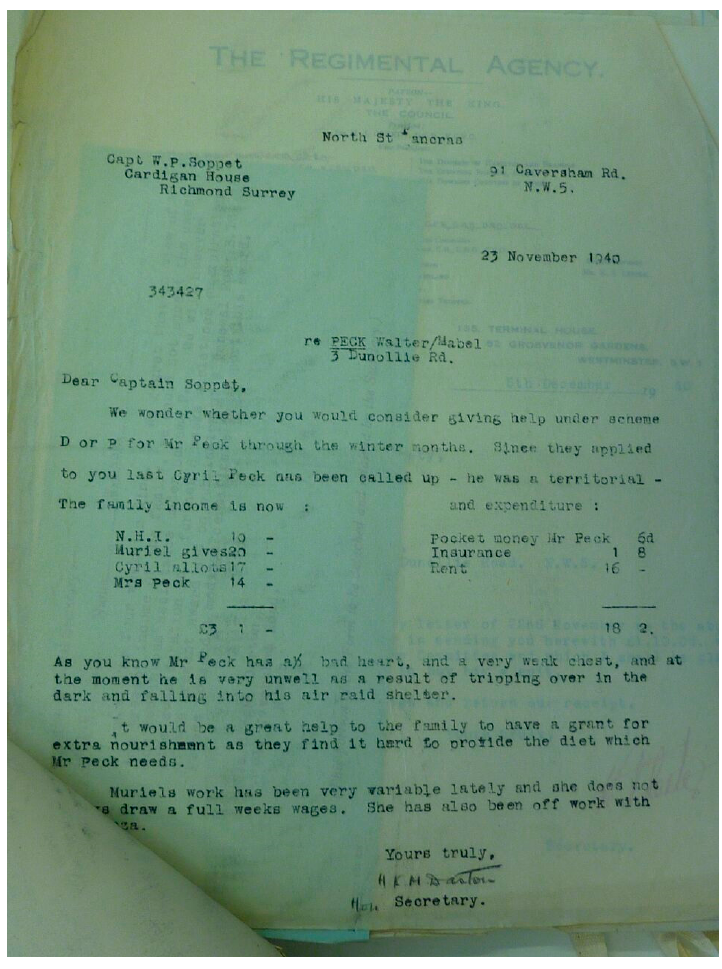
Figure 2. Copy of letter from COS requesting extra nourishment for Mr. Peck, 23 November 1940.